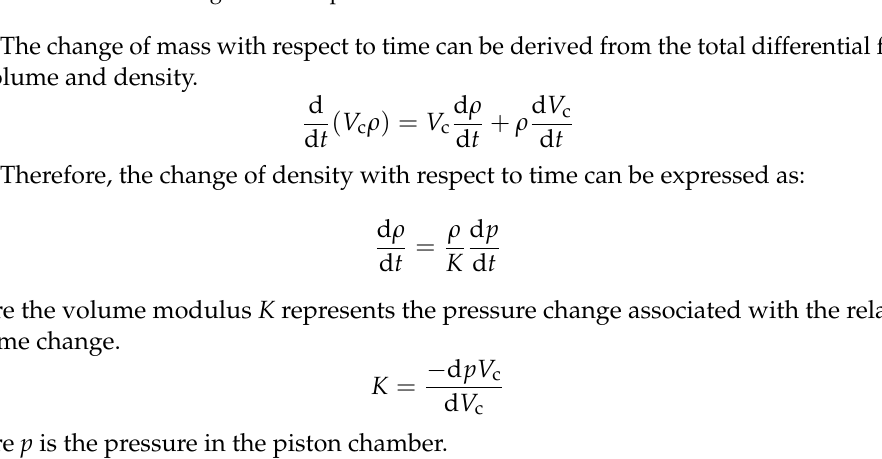
Figure 3. Flow balance diagram of the piston